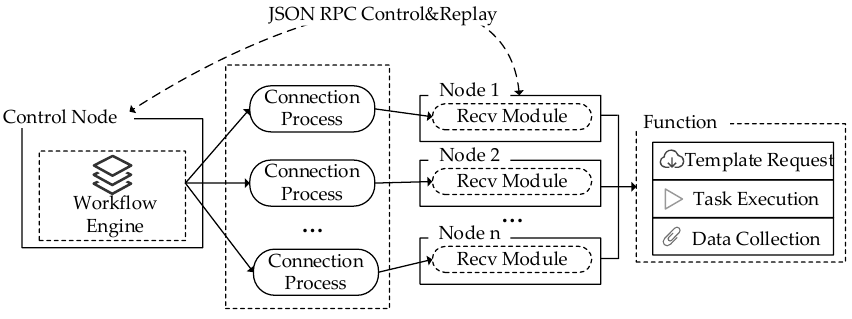
Figure 4. Communication architecture.